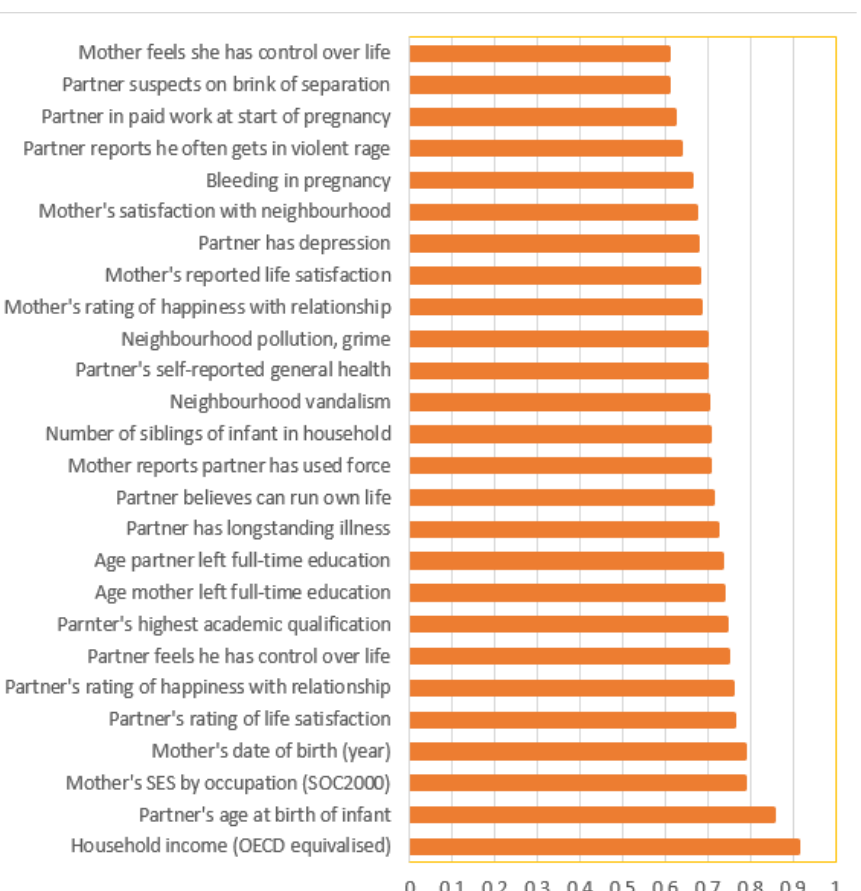
Figure 1. Importance scores for features with average importance scores above 0.6 in 72-feature RF algorithms predicting very premature birth before 32 weeks.